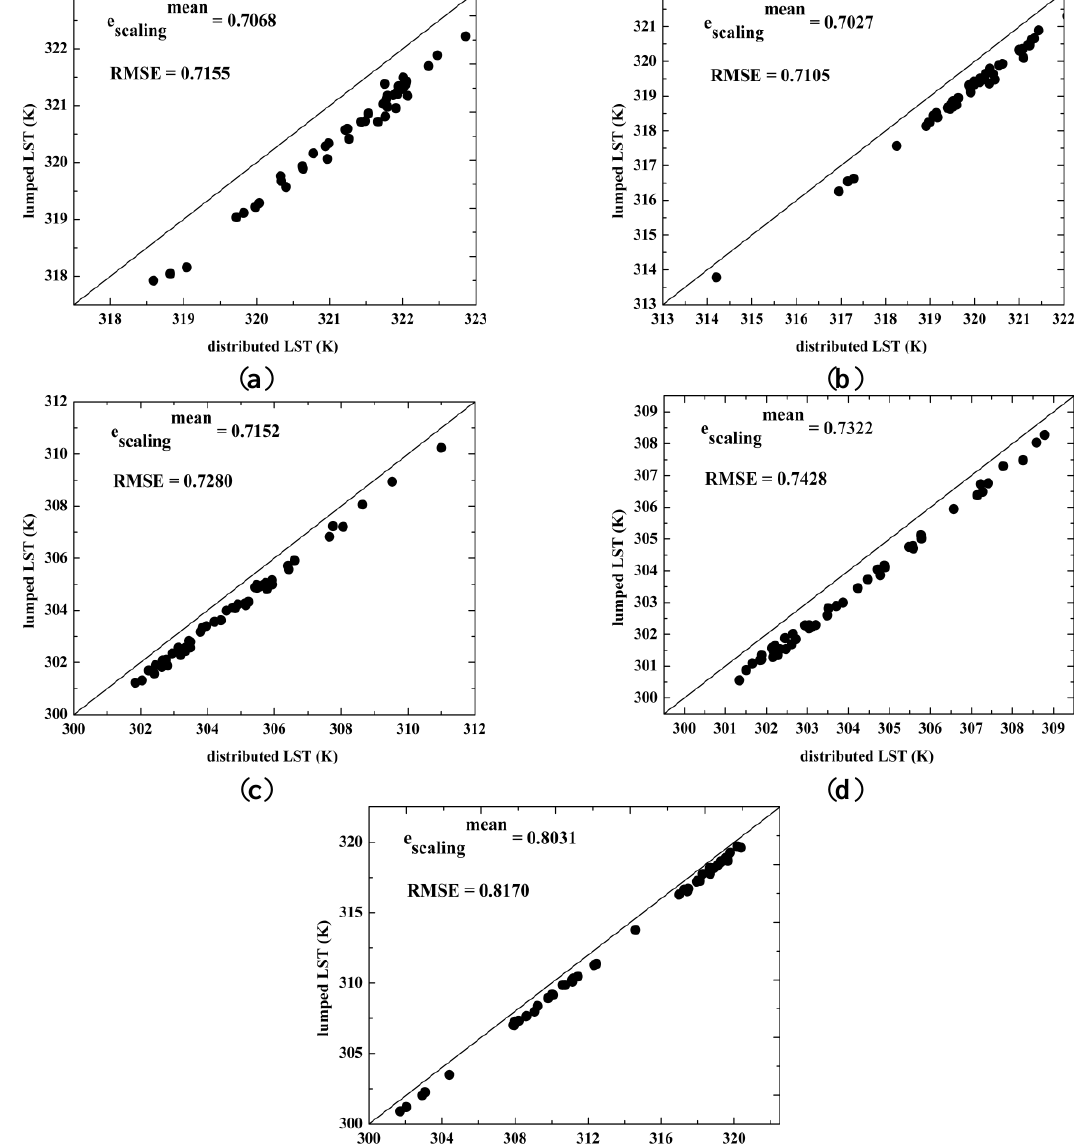
Figure 4. Pixel-by-pixel comparison of the distributed LST (with Method 1) and the lumped LST (300 m) at ( a ) Site 1, ( b ) Site 2, ( c ) Site 3, ( d ) Site 4 and ( e ) Site